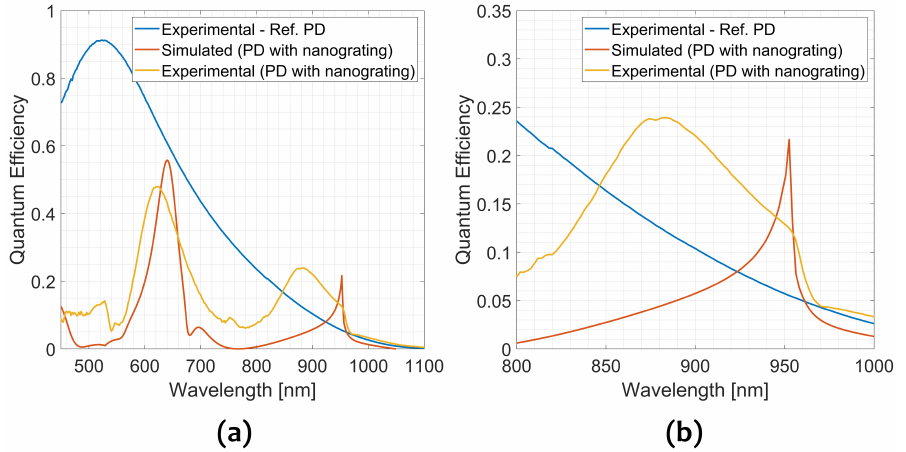
Figure 10. Measured QE of a reference PD (blue solid line), a fraction of absorbed light of the simulated structures (orange solid line) and measured QE of the integrated PD (yellow solid line) as a function of the incident wavelength in the range: ( a ) (450–1100) nm and ( b ) (800–1000) nm. Both simulated and QE of the integrated PD are lower than the QE curve of the reference at almost every wavelength except in the range around the wavelength of our interested 950nm.